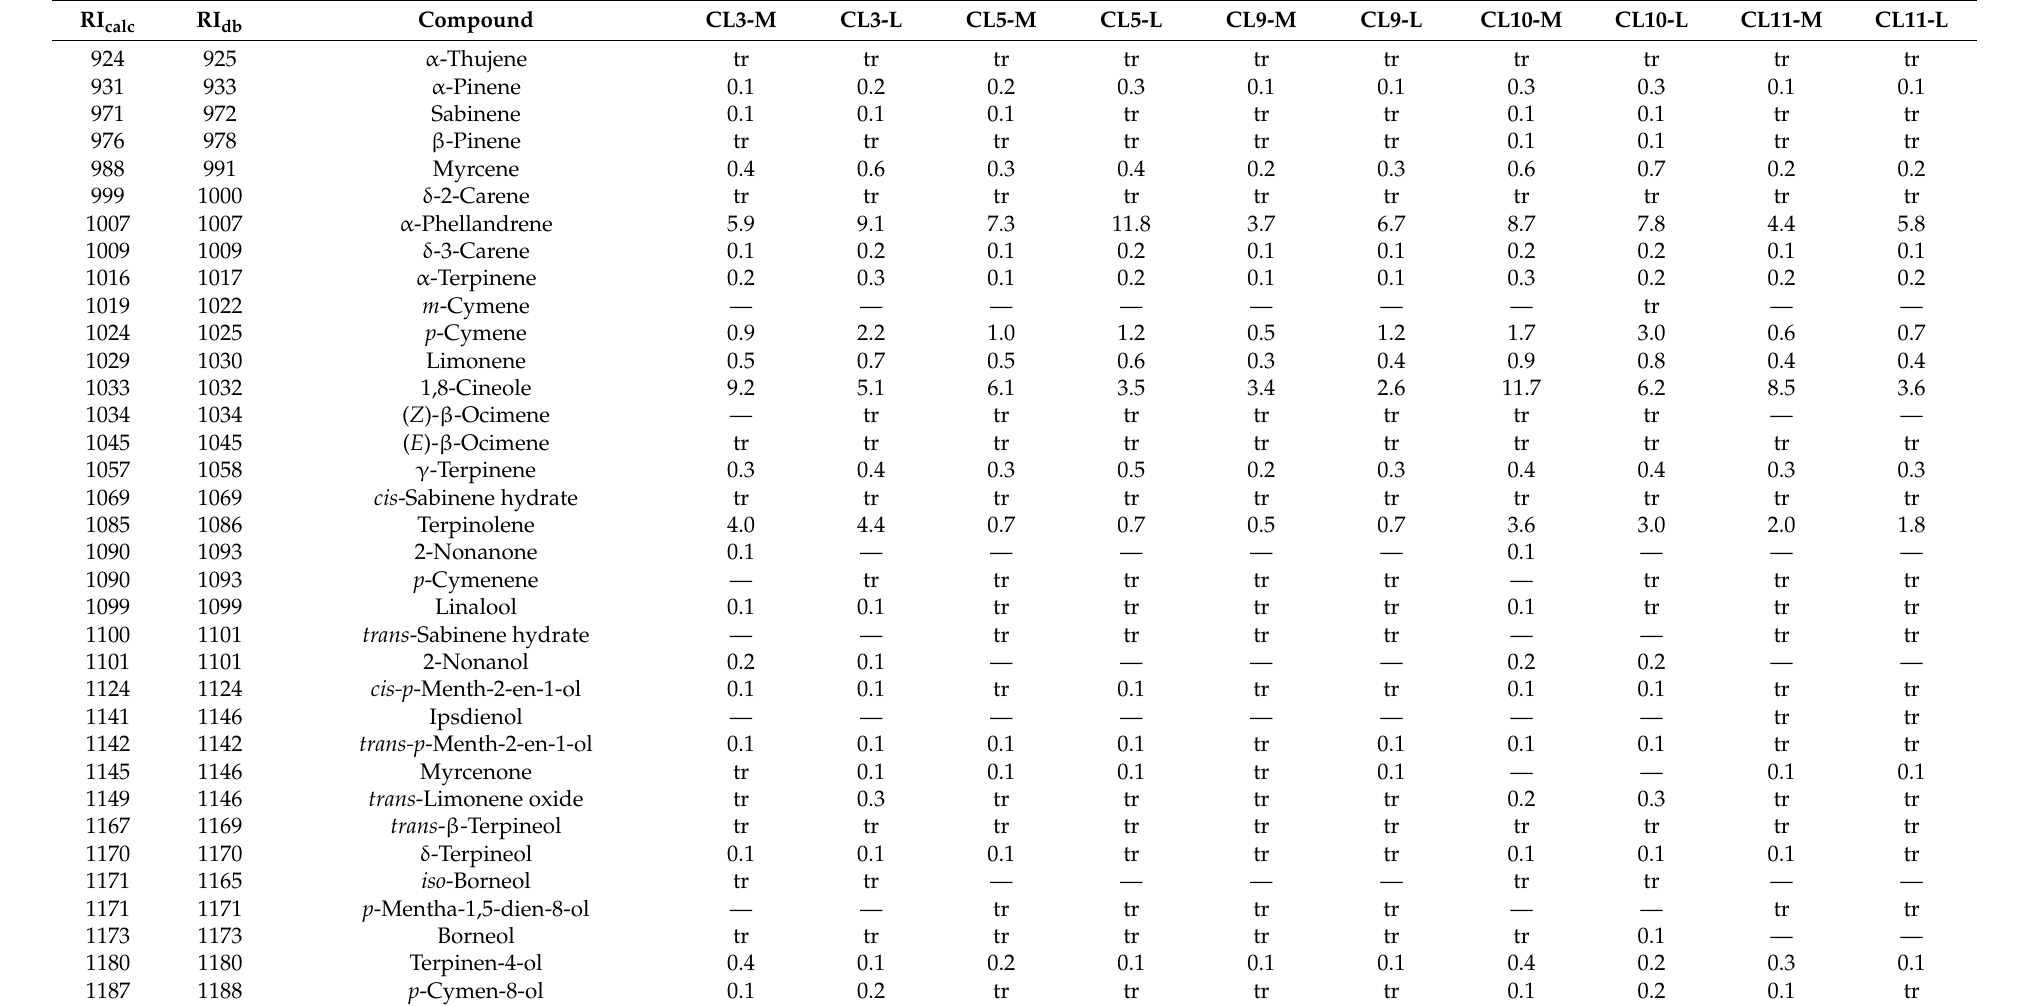
Table 2. Chemical compositions of “mother” and “lateral” rhizome essential oils of Curcuma longa varieties growing in north